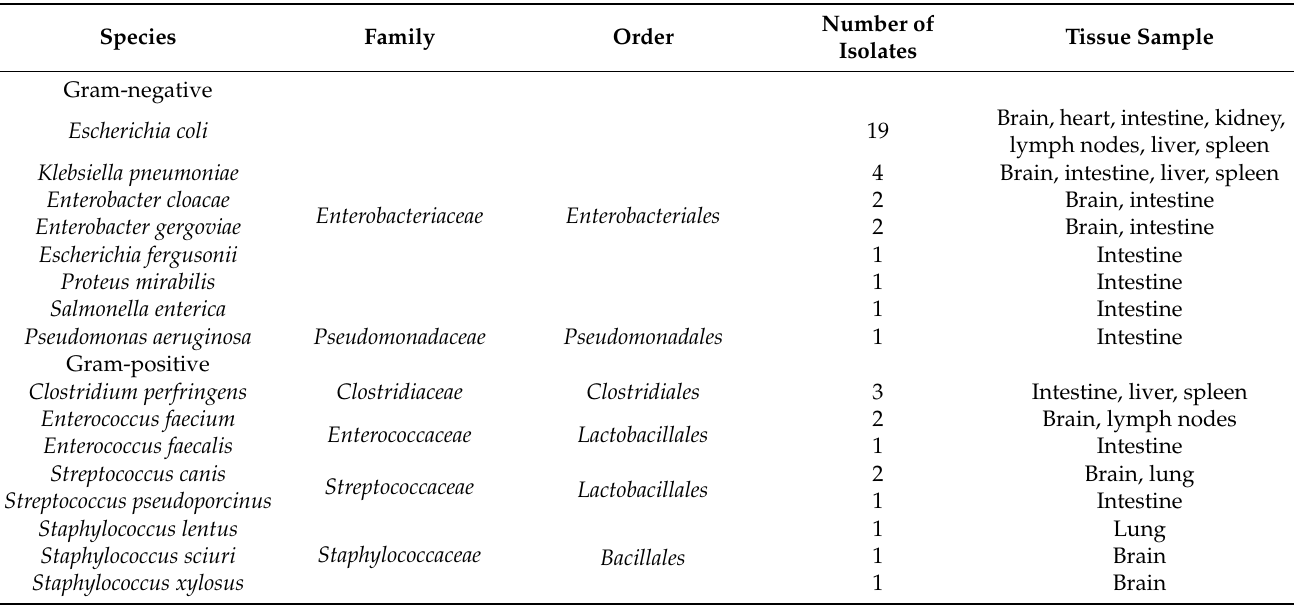
Table 1. Bacteria isolated from dogs with canine parvovirus